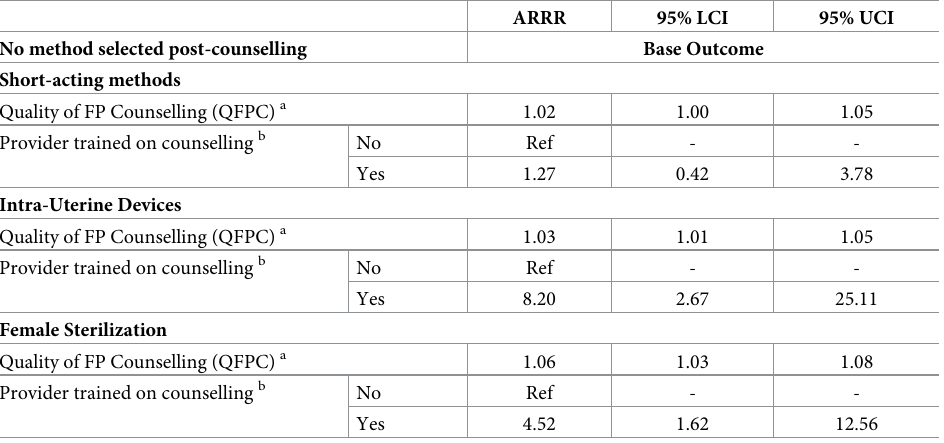
Table 5. Multinomial logistic regression models to test the association between type of FP method selected post- counselling and a) Quality of FP Counselling (QFPC) and b) training of providers on FP counselling (N = 237). ARRR 95% LCI 95% UCI No method selected post-counselling Base